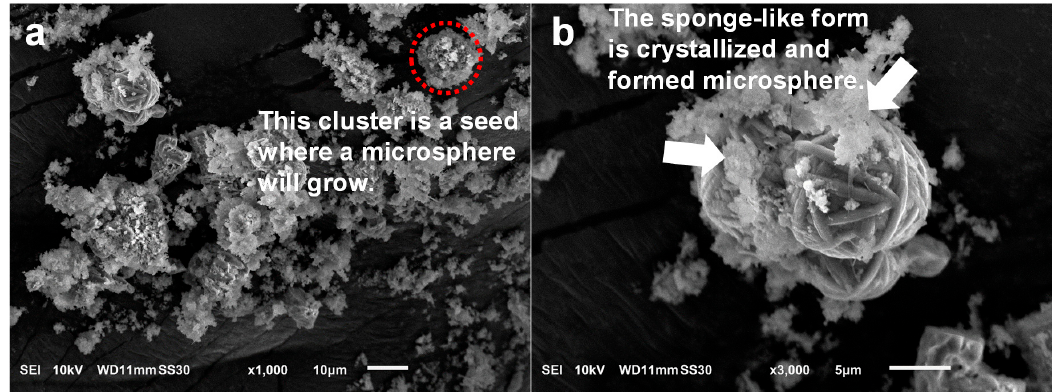
Figure 6. SEM images of DBM after hydrothermal treatment of DE for 4 h. ( a ) Microsphere growth from a cluster (dotted red circle); ( b ) mesophase on the surfaces of the microspheres.